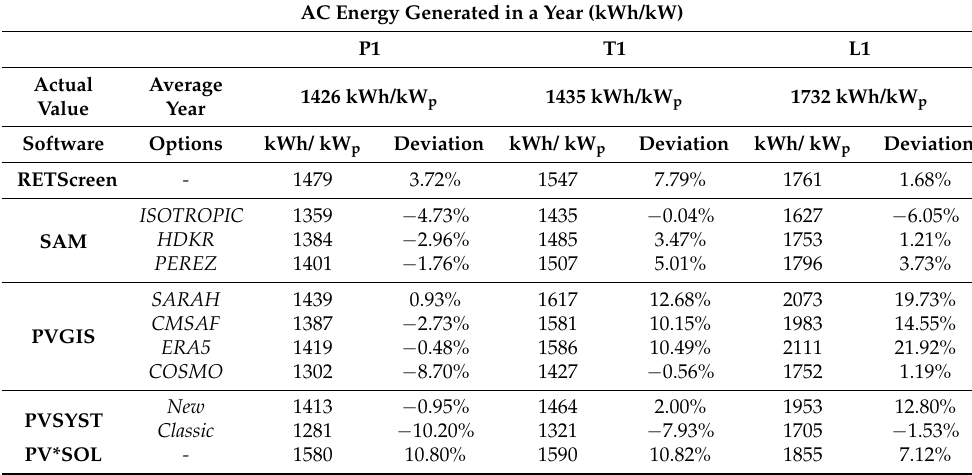
Table 4. Yearly energy results comparative of each